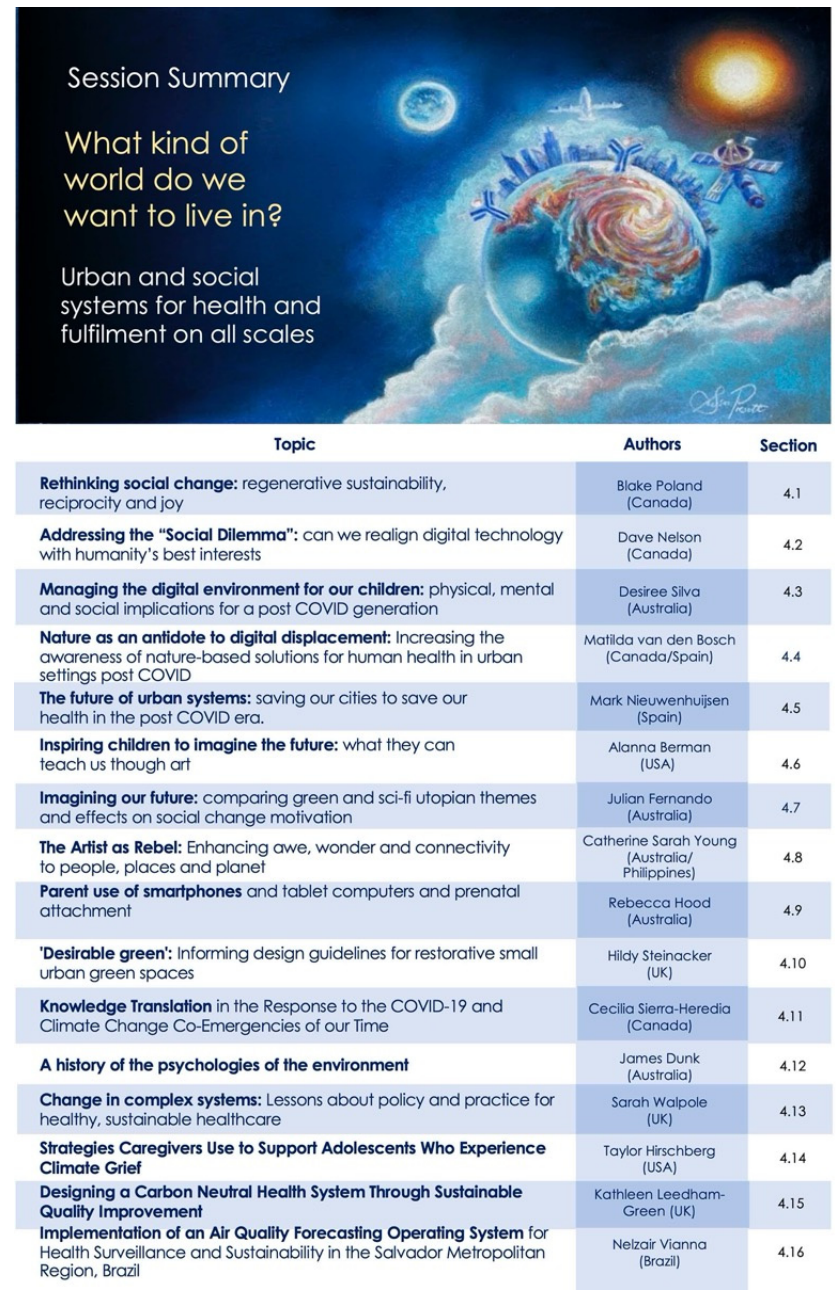
Figure 3. What kind of world do we want to live in? Overview of topics and speakers in the session on urban and social systems for health and fulfilment.